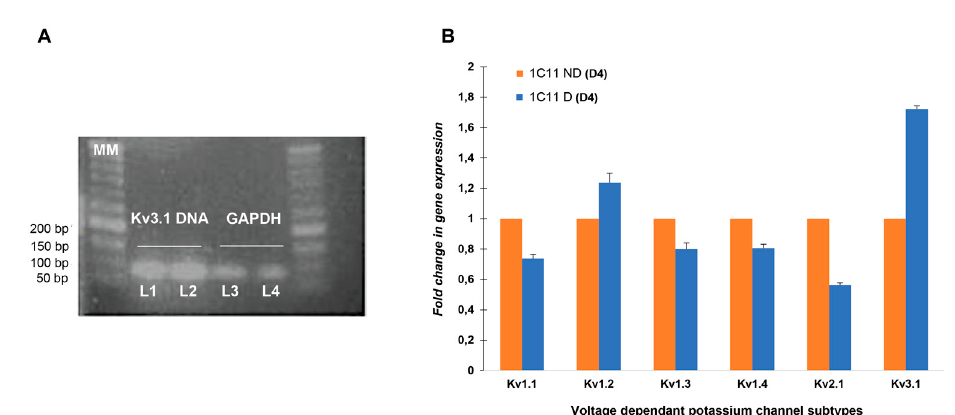
Figure 1. ( A ). The gel electrophoresis of Kv3.1b using Kv3.1 and 2 primers for the characterization of the expression of kv3.1b, isolated from 1C11 serotonergic neuronal stem cells. (MM) Molecular weight